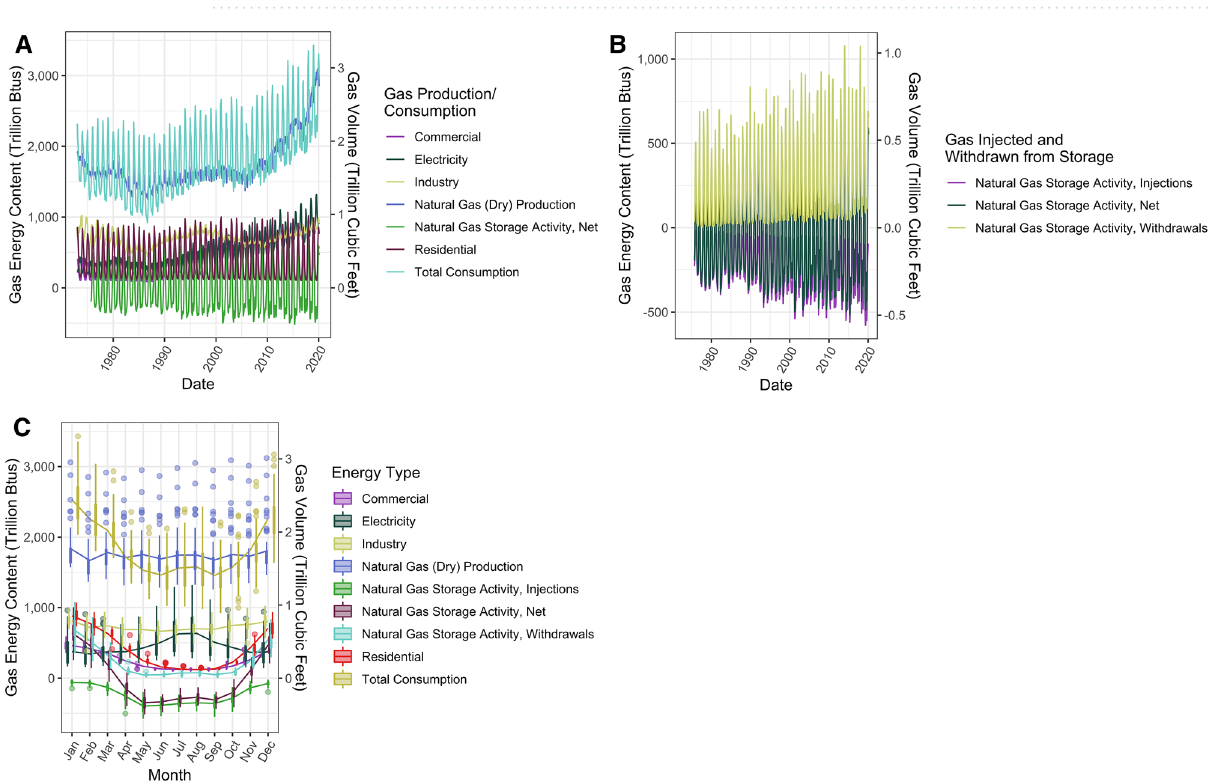
Figure 2. U.S. natural gas production, consumption, and storage from January 1973 to February 2020. ( A ) Monthly gas production and consumption; ( B ) monthly gas storage activity; and ( C ) monthly average gas